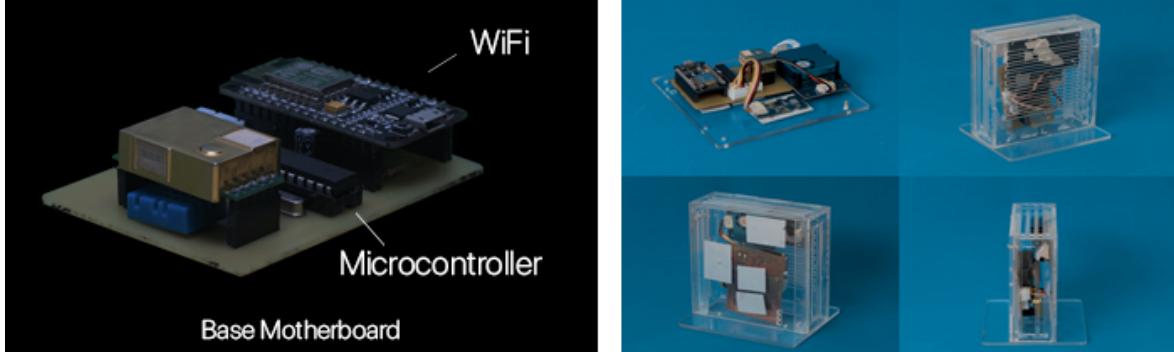
Figure 3. Hardware Architecture of Indoor air quality monitoring node.